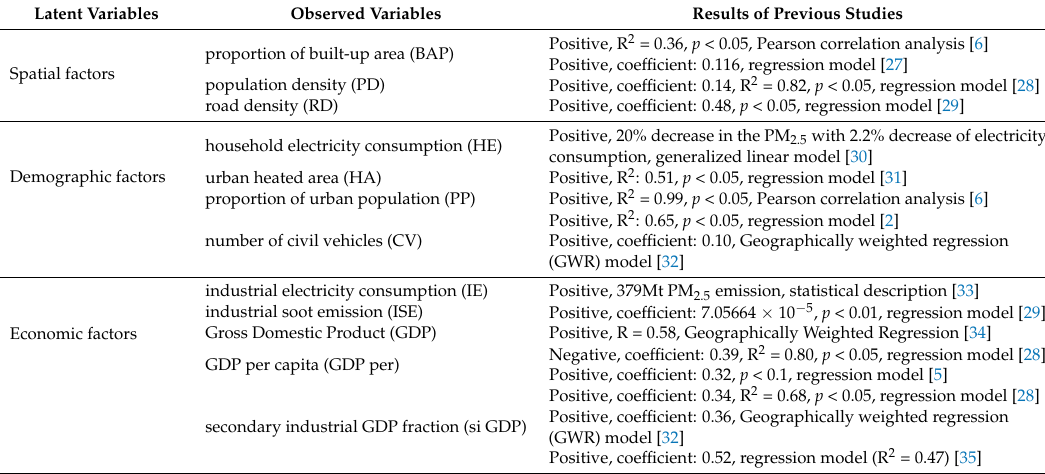
Table 1. Summary of the results of previous correlation